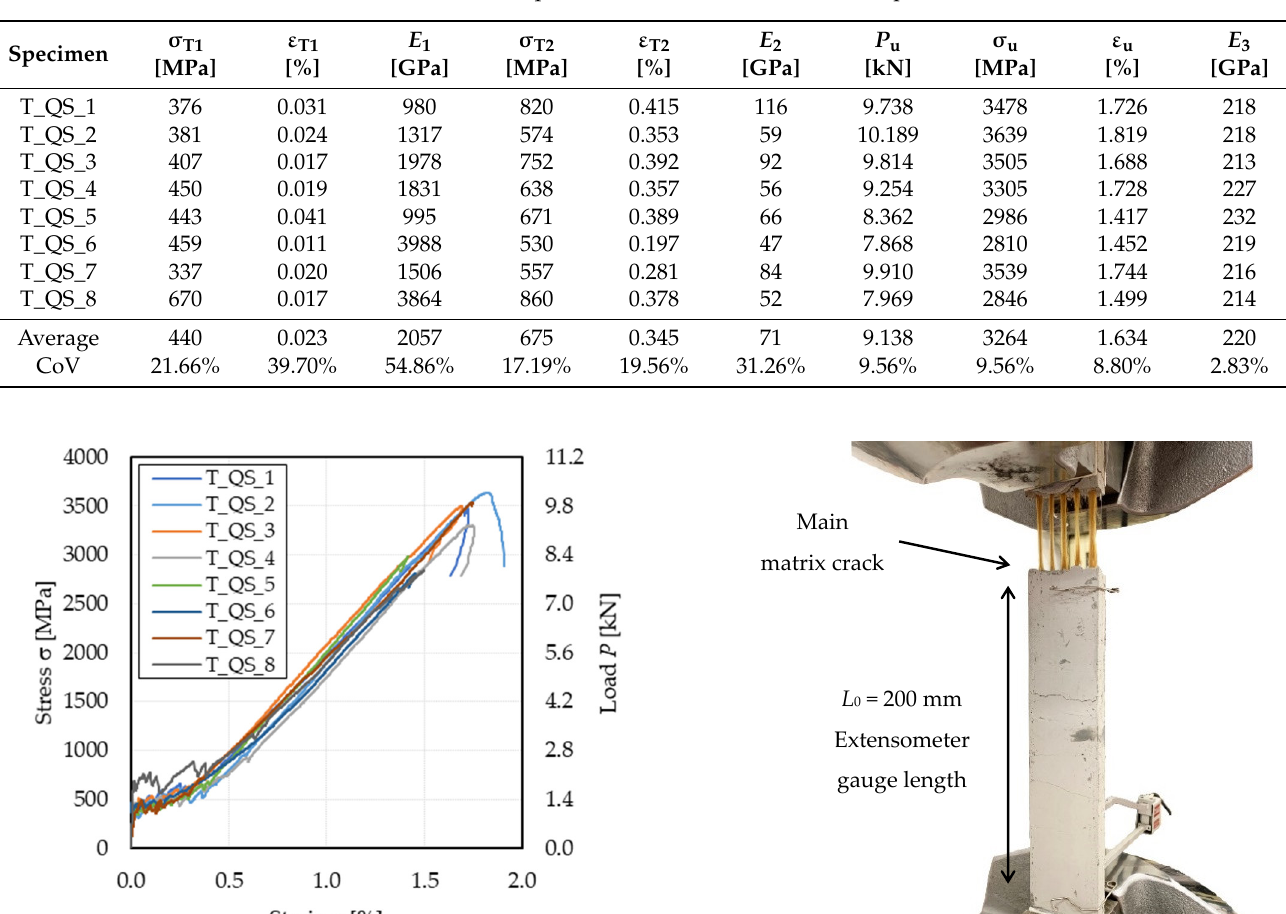
Table 2. Results of quasi-static tensile test on FRCM coupons.